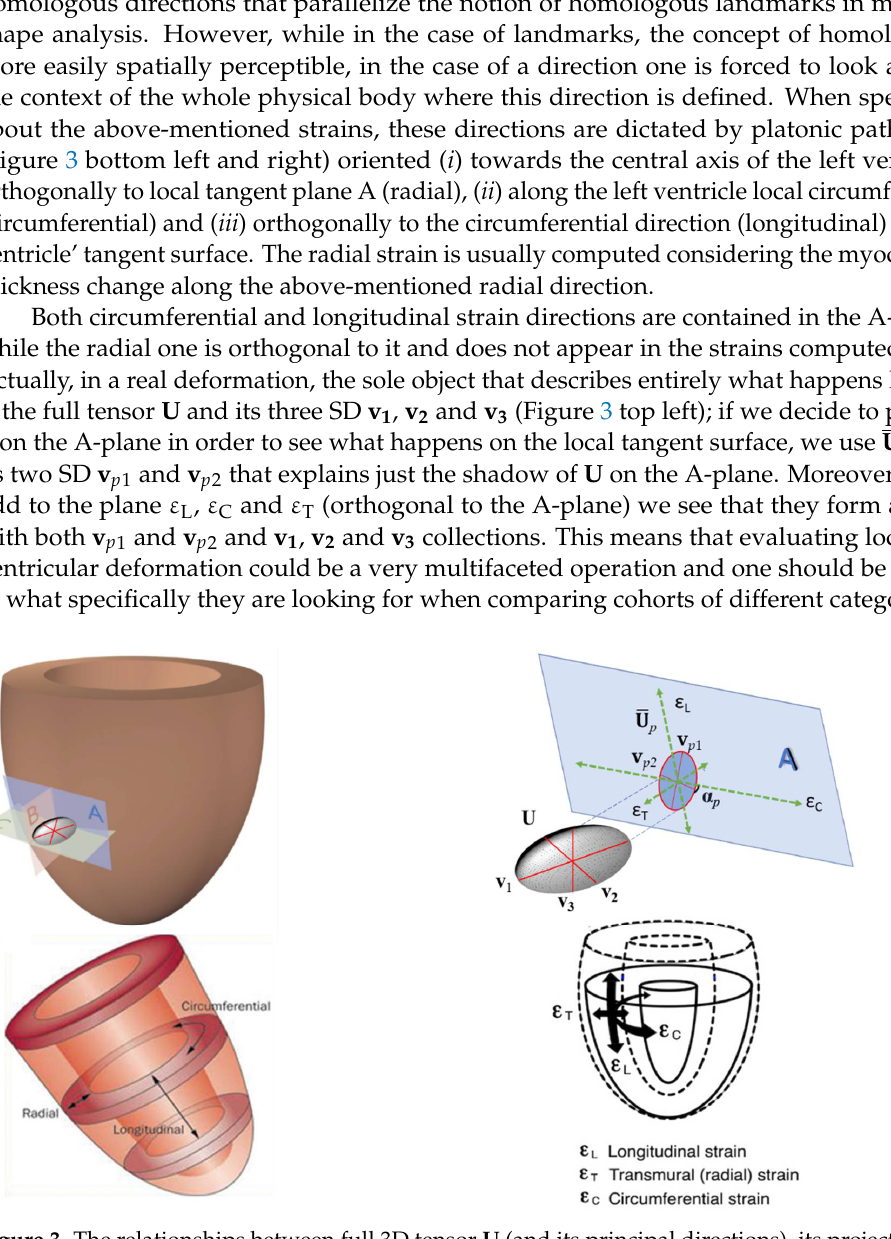
Figure 3. The relationships between full 3D tensor U (and its principal directions), its projection U p on the local surface tangent plane and the classic radial, circumferential and longitudinal 3D-STE strains. Modified from [10].